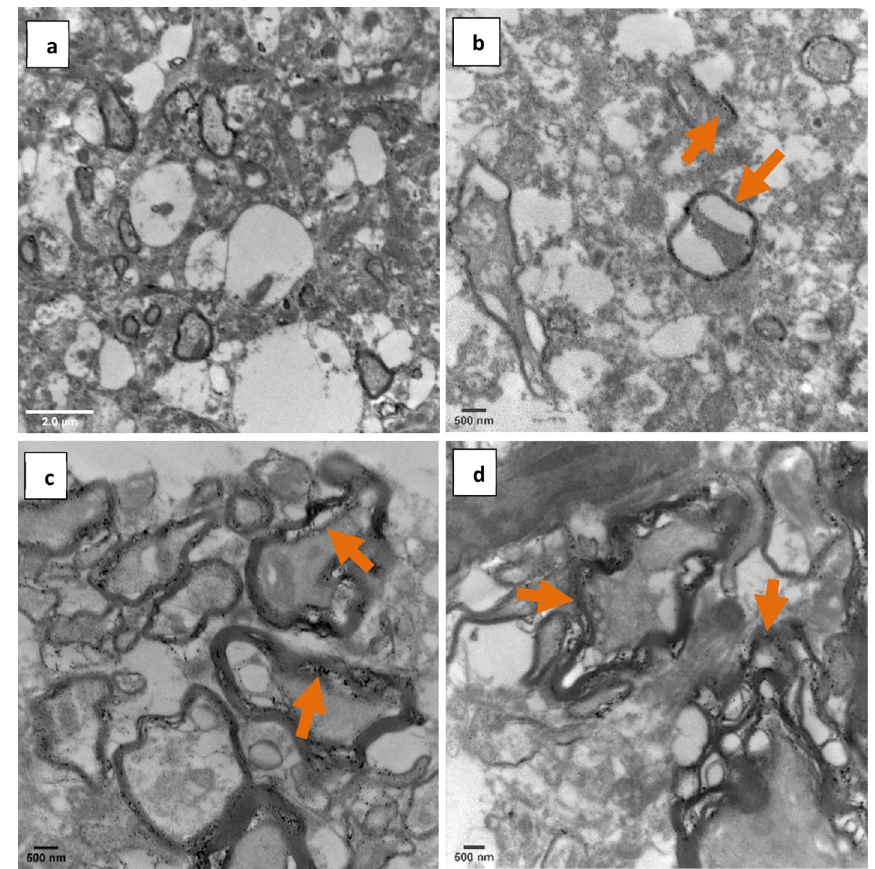
Figure 7. TEM Micrographs of AgNPs in brain tissues: ( a ) Control group, at magnification ×15,000 and scale bar 2.0 μm, shows no change in the ultrastructure of myelinated axons (white arrows). ( b ) The low dose group (0.5 mg/kg), at magnification ×12,000 and scale bar 500 nm, shows slight structural changes in the myelinated axons and their cytoplasm (orange arrows). ( c , d ): Medium dose group (5 mg/kg), at magnification ×12,000 and ×10,000 respectively, and scale bar 500 nm, shows higher concentrations of biosynthesized AgNPs in the myelin lamella and their increased structural disturbance (orange